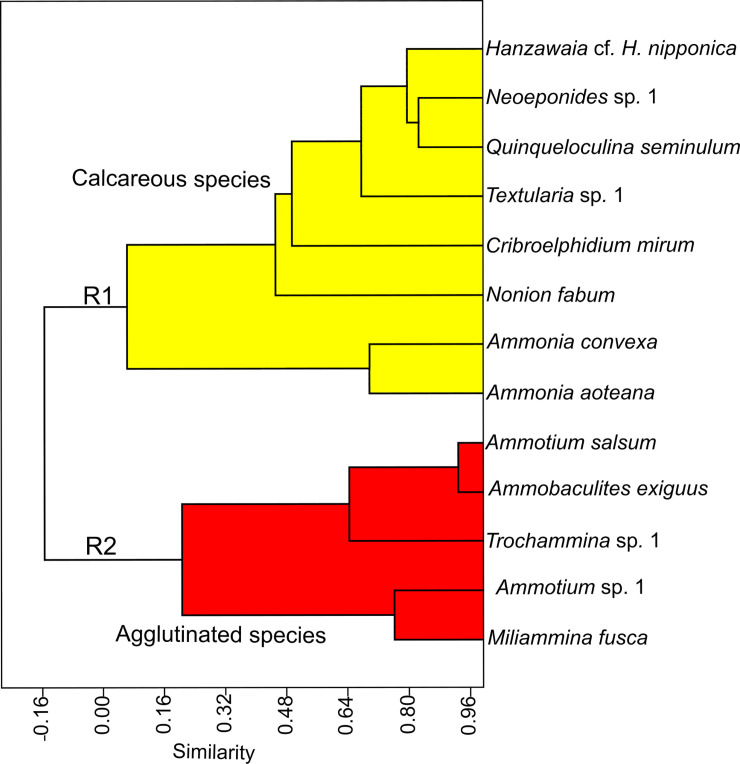
Species dendrogram produced by the R-mode cluster analysis using the correlation coefficient matrix.Note that R-mode clusters reflect test wall types (agglutinated versus hyaline-perforate/porcelaneous).